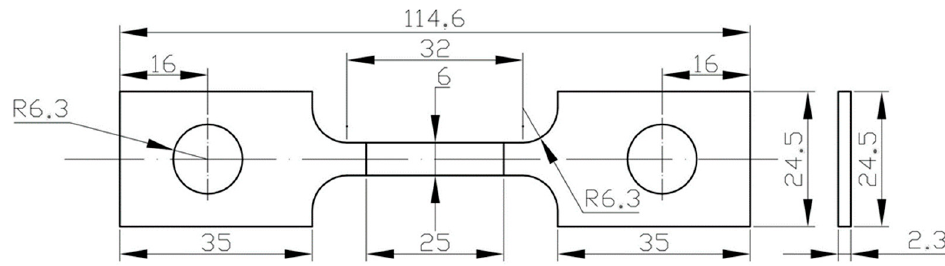
Figure 1. Creep rupture test sample (unit: mm).